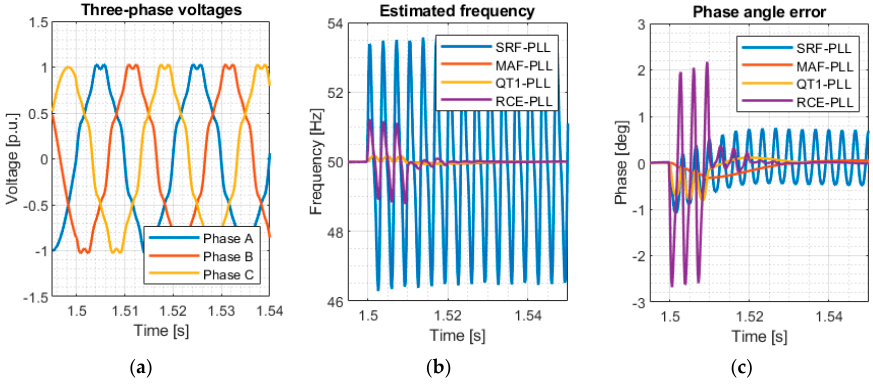
Figure 13. Voltage harmonics test. ( a ) Grid voltage waveforms; ( b ) estimated grid frequency; ( c ) phase angle error.